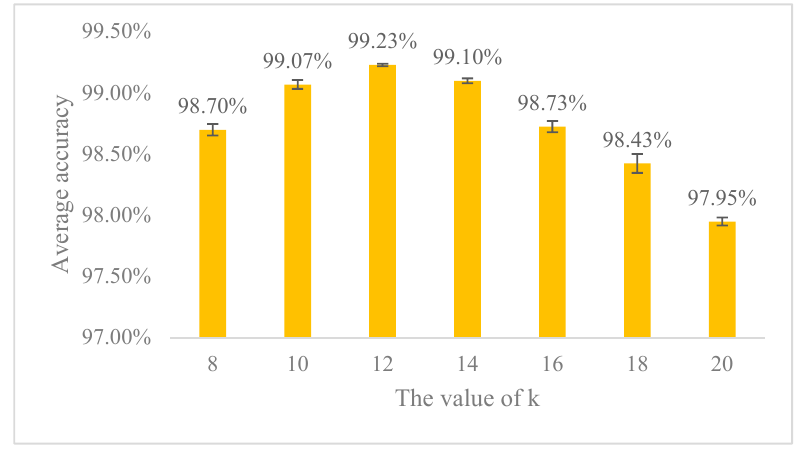
Figure 13. GL-mRMR-SVM results with different k under compound fault.